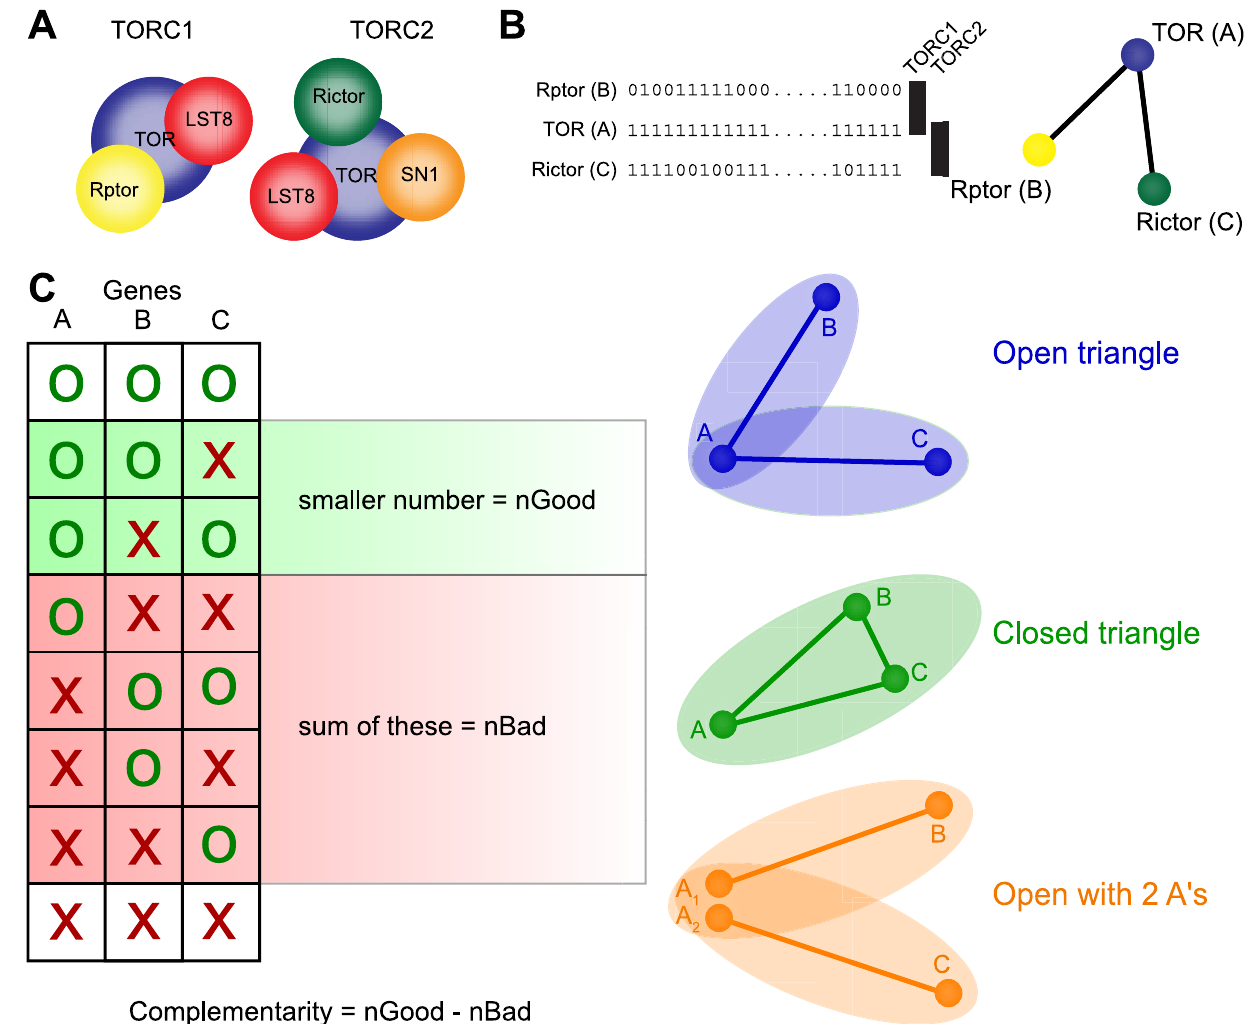
Figure 1. Visualization of complementarity score and illustration of triangle types. (A) Constitution of the two TOR sub-complexes TORC1 and TORC2 complex. (B) Phylogenetic profiles (as an example) of TOR and Rptor and Rictor and the formed triangle. The nodes represent proteins and the lines indicate a pairwise interaction. (C) Visualization of the complementary score and the different triangle types used throughout the study. We consider ‘‘open’’ and ‘‘closed’’ triangles and closed triangles with 2 inparalogs. The ellipses symbolize the different complexes. doi:10.1371/journal.pcbi.1003124.g001 connected components, as opposed to cliques in the original OMA algorithm) and then alignments with only 25% sequence coverage